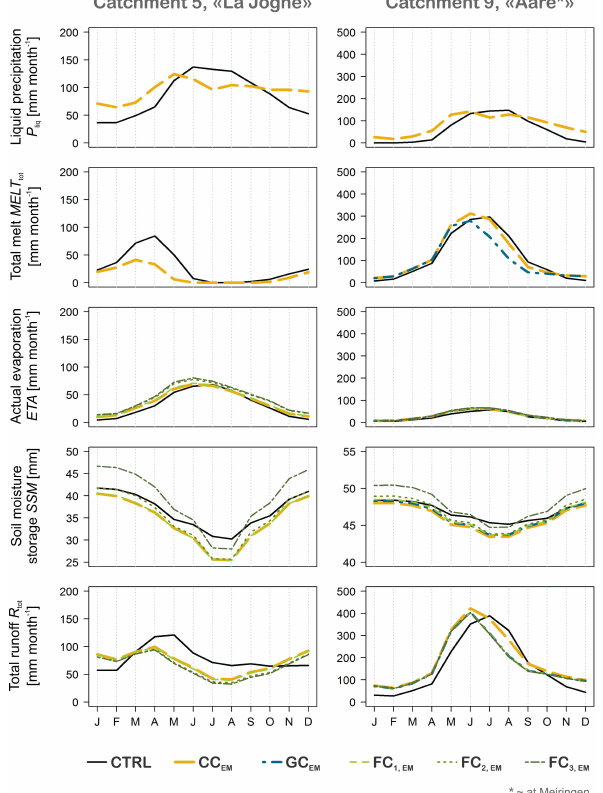
Fig. 5. Mean annual cycle of different water balance components ( P liq , MELT tot , ETA, SSM, R tot ; rows 1 to 5) for the non-glaciated catchment La Jogne (No. 5, left column) and the glaciated catch- ment Aare (No. 9, right column). Total melt is the sum of snow- and ice-melt, but only the glaciated catchment 9 has ice-melt, of course. For all curves except for that of the control period (CTRL), the ensemble mean is displayed (CC EM , GC EM , FC 1, EM , FC 2, EM , FC 3, EM )